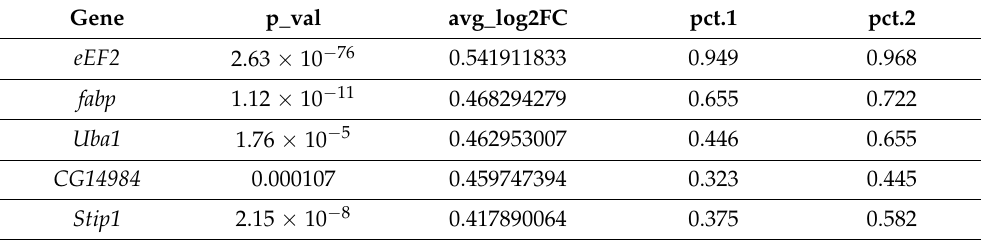
Table A2. DEGs of fate undetermined cells. DEG list generated with cutoff value of log2FC